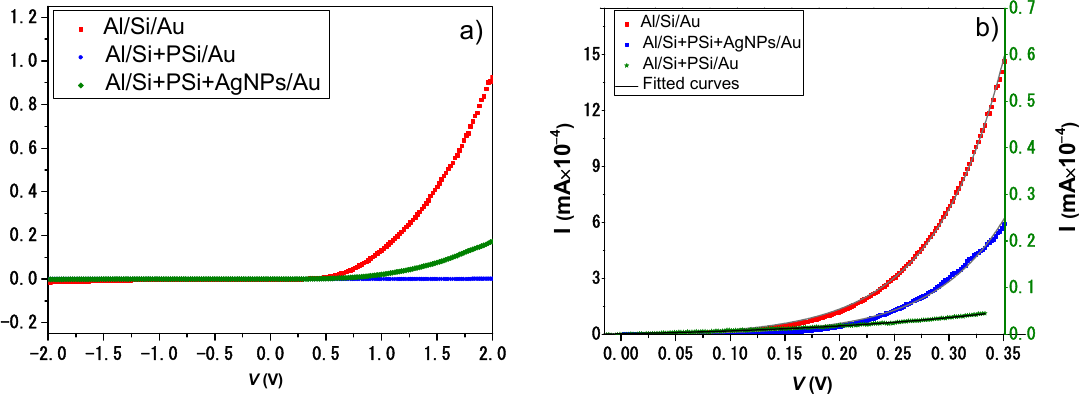
Figure 6. Electrical DC measurements in dark state: ( a ) current–voltage curves for the three Schottky diodes under forward and reverse biasing; ( b ) experimental current–voltage data under forward biasing and fitting to the modified diode model to extract the electrical parameters of Schottky di- odes.